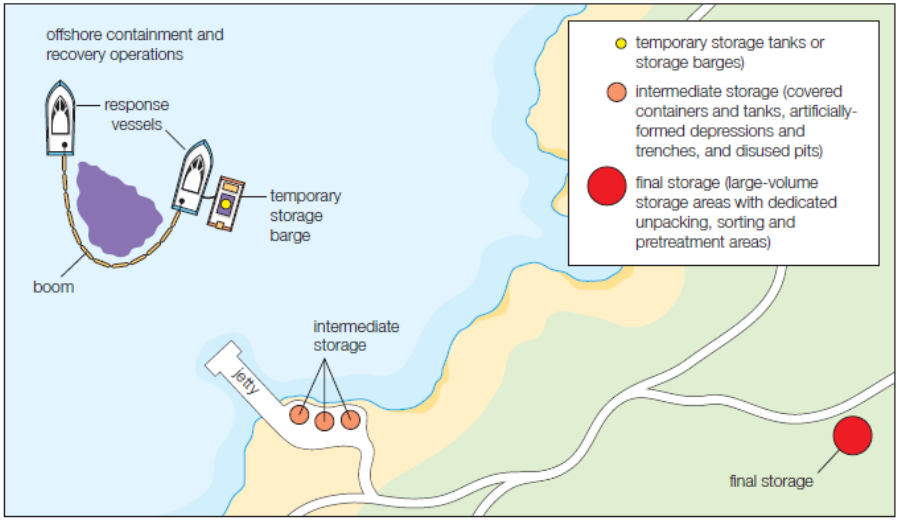
Figure 2. Transportation and Storage Requirements Associated With Onshore Transfer of Recovered Oil and Water During Oil Spill Response (Source: IPIECA-IOGP Joint Industry Project, 2013).